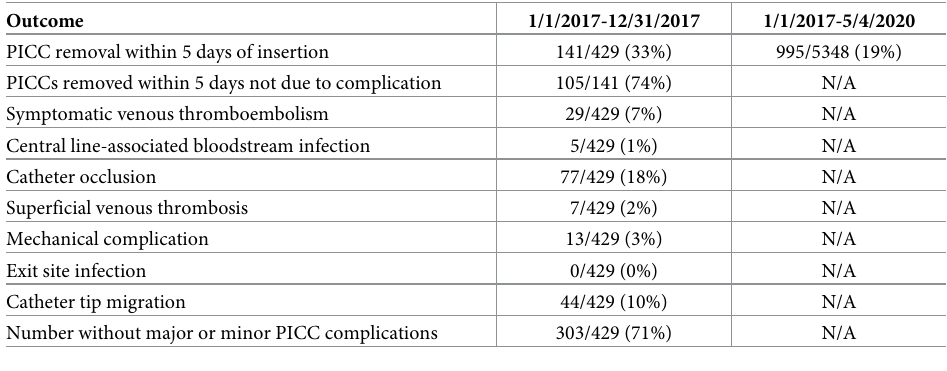
Table 2. Outcomes of patients with